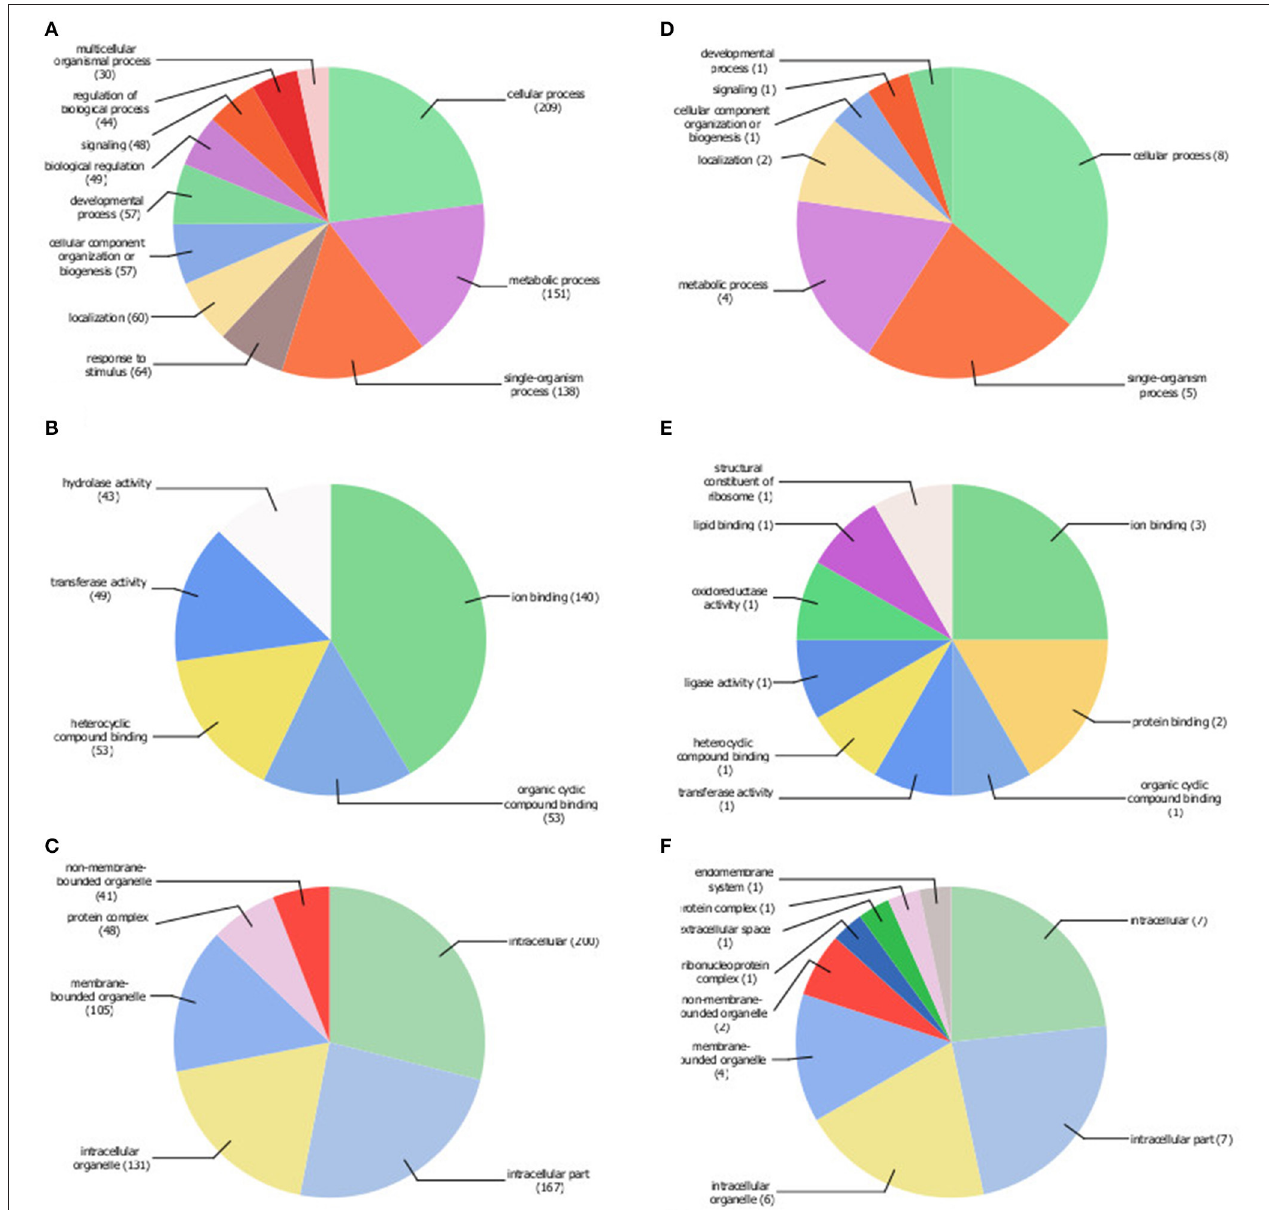
FIGURE 2 | Gene ontology (GO) terms associated with young (A–C) and old (D–F) erythrocyte age classes. Pie charts were generated at level 2 for biological process (A,D) , and level 3 for molecular function (B,E) and cellular component (C,F) by Blast2GO using 742 transcripts with higher levels in young erythrocytes ( Table S2 ; pie charts A–C ) and 34 transcripts with higher levels in old erythrocytes ( Table 2 ; pie charts D–F) as